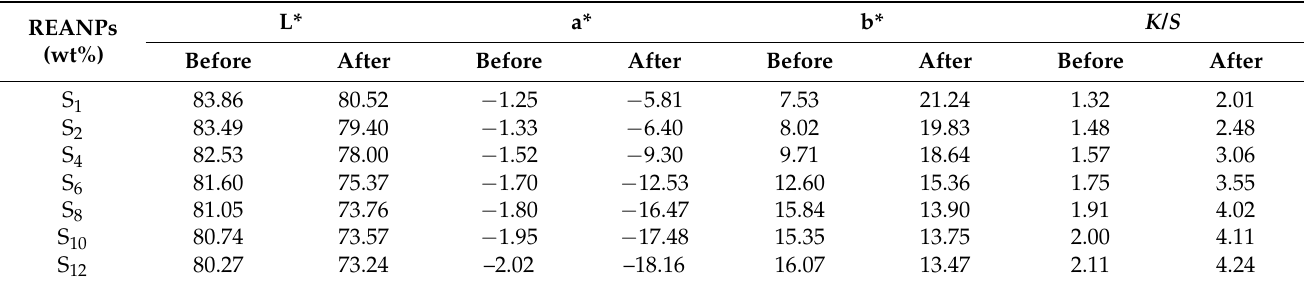
Table 3. Color space values of coated cellulosic fabrics before and after 100 s of ultraviolet irradiation at various pigment